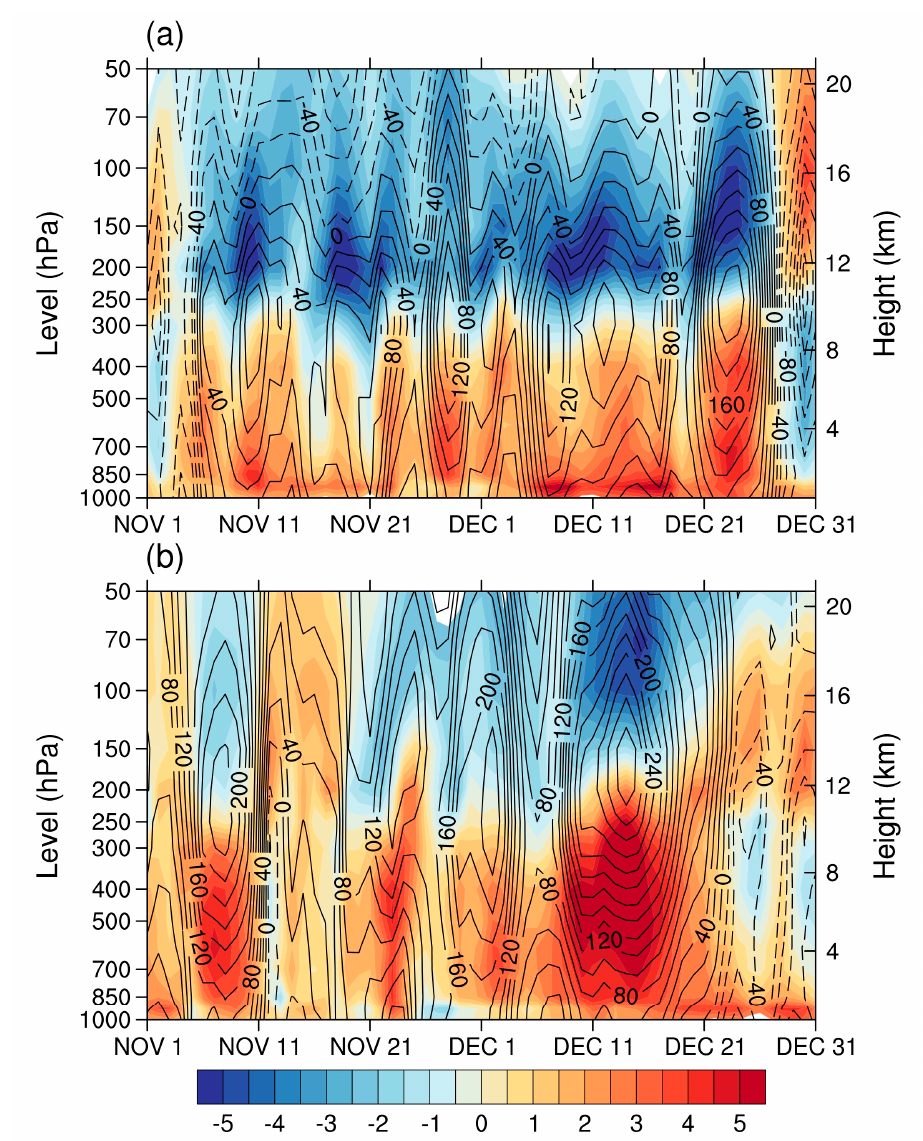
Figure 4. The temporal evolution of air temperature anomalies (shading, in °C) and geopotential height anomalies (contour, in gpm) averaged over the blob area from 1 November to 31 December of ( a ) 2019 and ( b ) 2001, respectively.